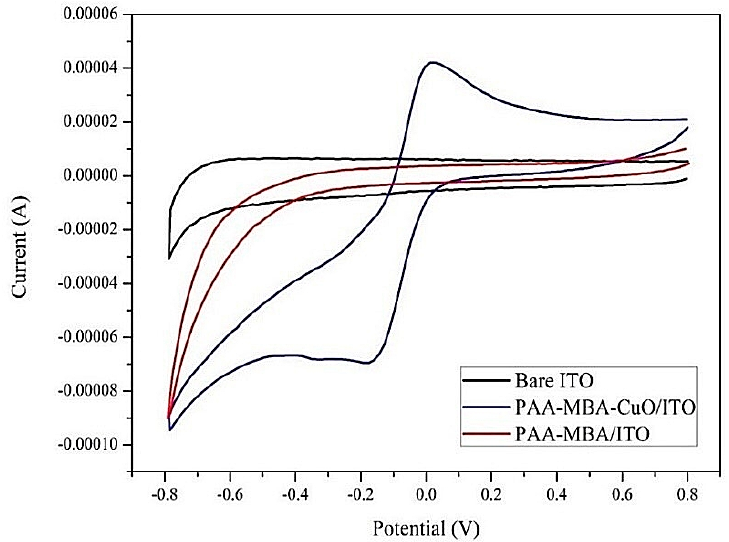
Figure 5. Cyclic voltammograms of the bare ITO, MBA–PAA/ITO, and CuO–MBA–PAA electrode in 0.1M phosphate buffer solution (PBS) (pH = 7.4).